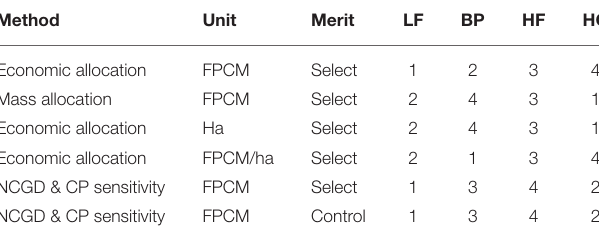
TABLE 11 | Ranked dairy system mean total GHG emissions (kg CO 2